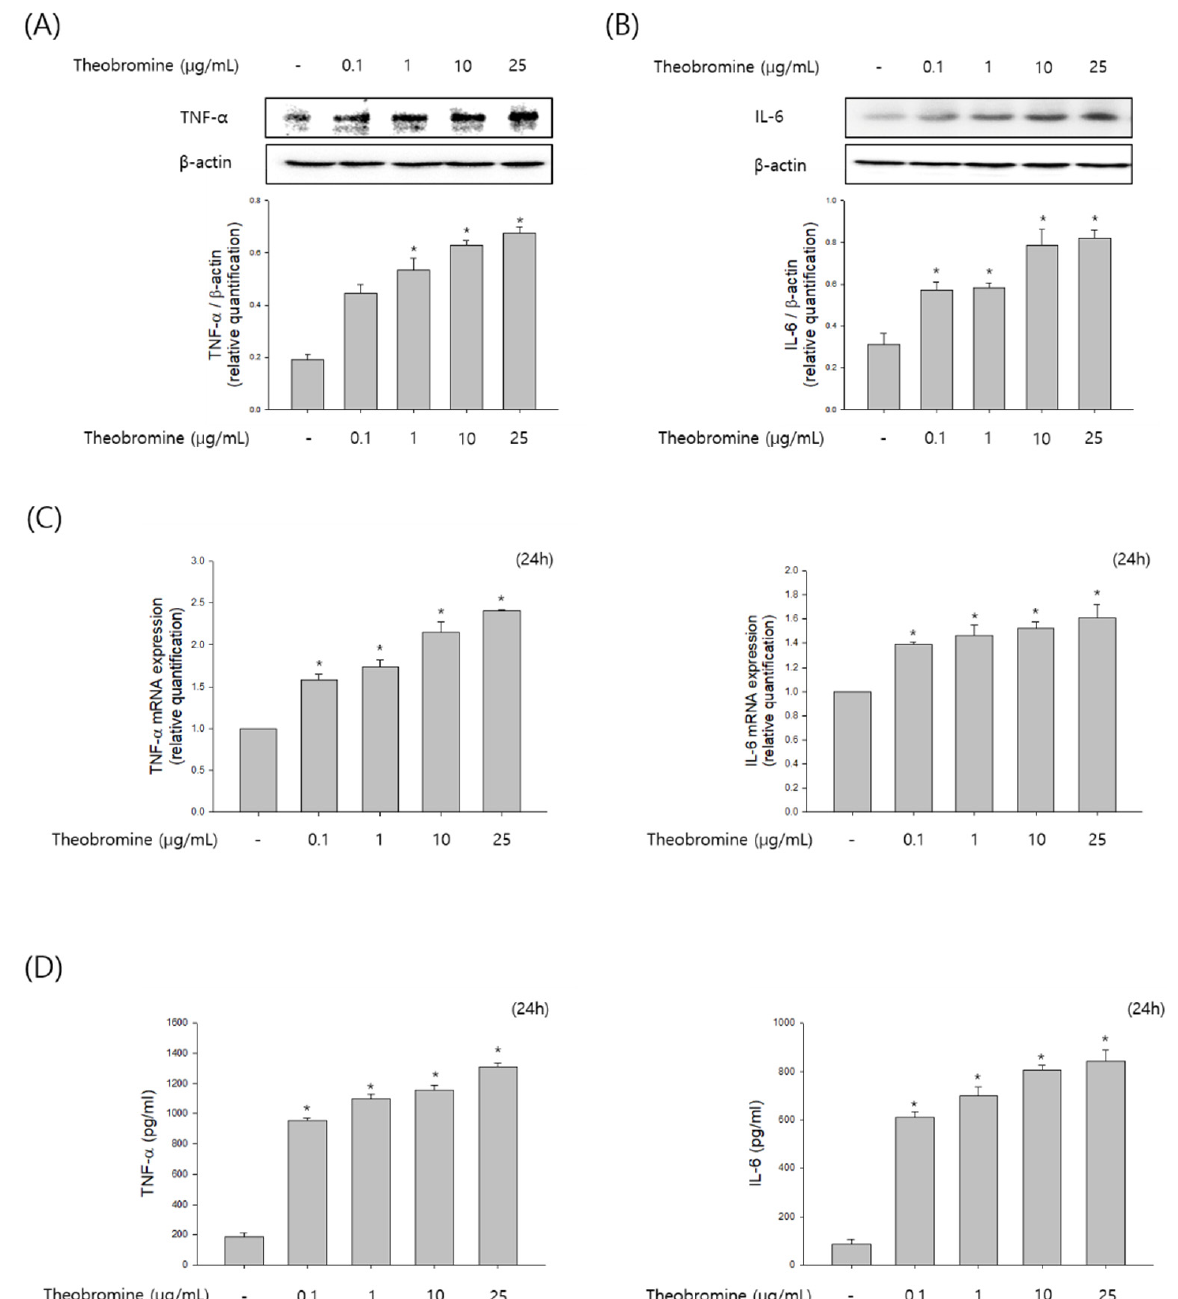
Figure 3. Effect of theobromine on the secretion of inflammatory cytokines in RAW 264.7 macrophages. RAW 264.7 macrophages were treated with the indicated concentrations of theobromine for 24 h. ( A , B ) The protein expressions of TNF- α and IL-6 were determined using Western blot assay. ( C ) The mRNA levels of TNF- α and IL-6 were determined by RT-PCR. ( D ) The secretion amounts of TNF- α and IL-6 were measured using an ELISA kit. Results are presented as means ± SEM of quintuplicates from a representative experiment. * p < 0.05, compared with the untreated group.